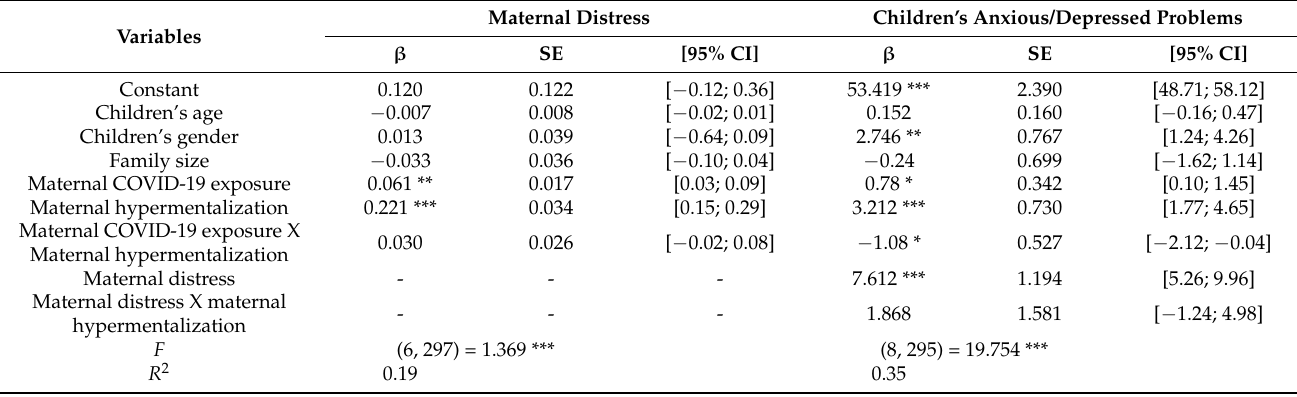
Table 2. Moderated Mediation Model—Model